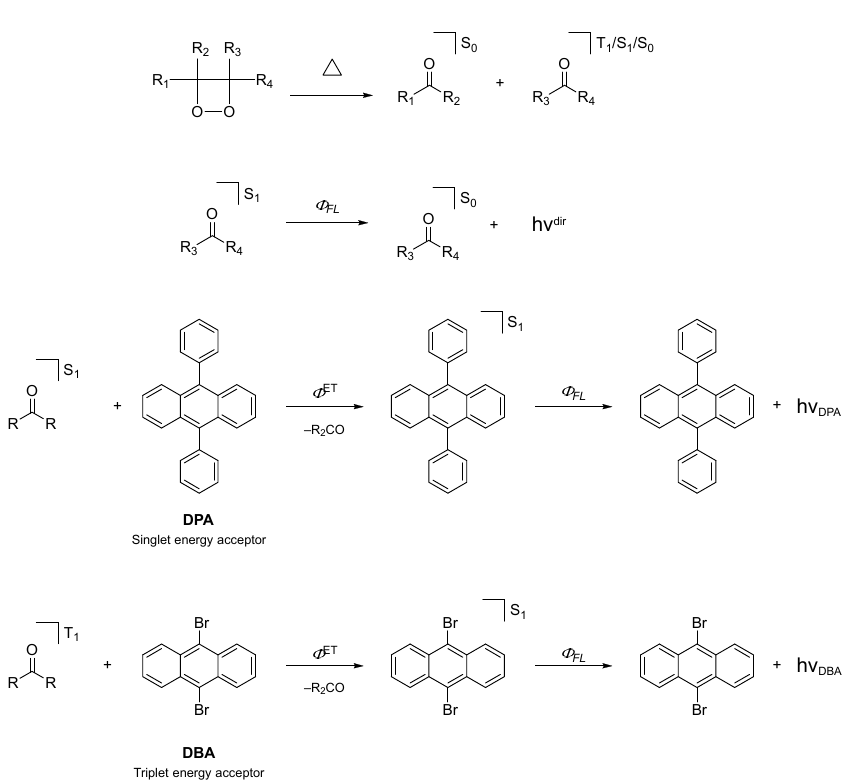
Scheme 4. Unimolecular decomposition of 1,2-dioxetanes. Isothermal decomposition kinetics